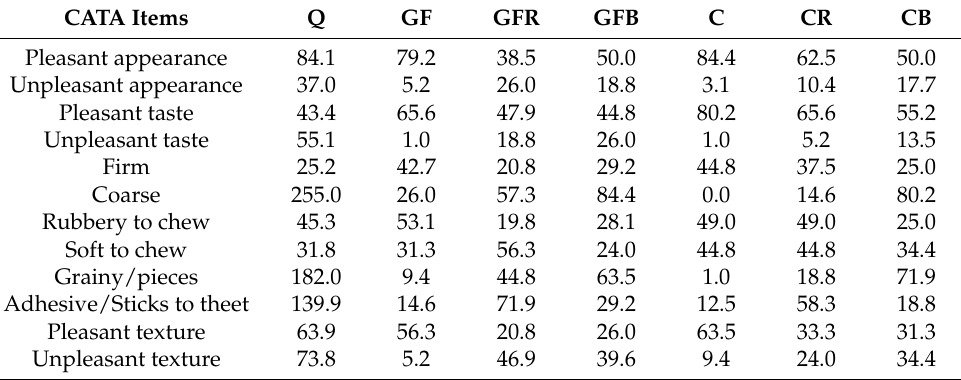
Table 4. Frequency mention (%) of Check-All-That-Apply (CATA) items for each cooked gnocchi